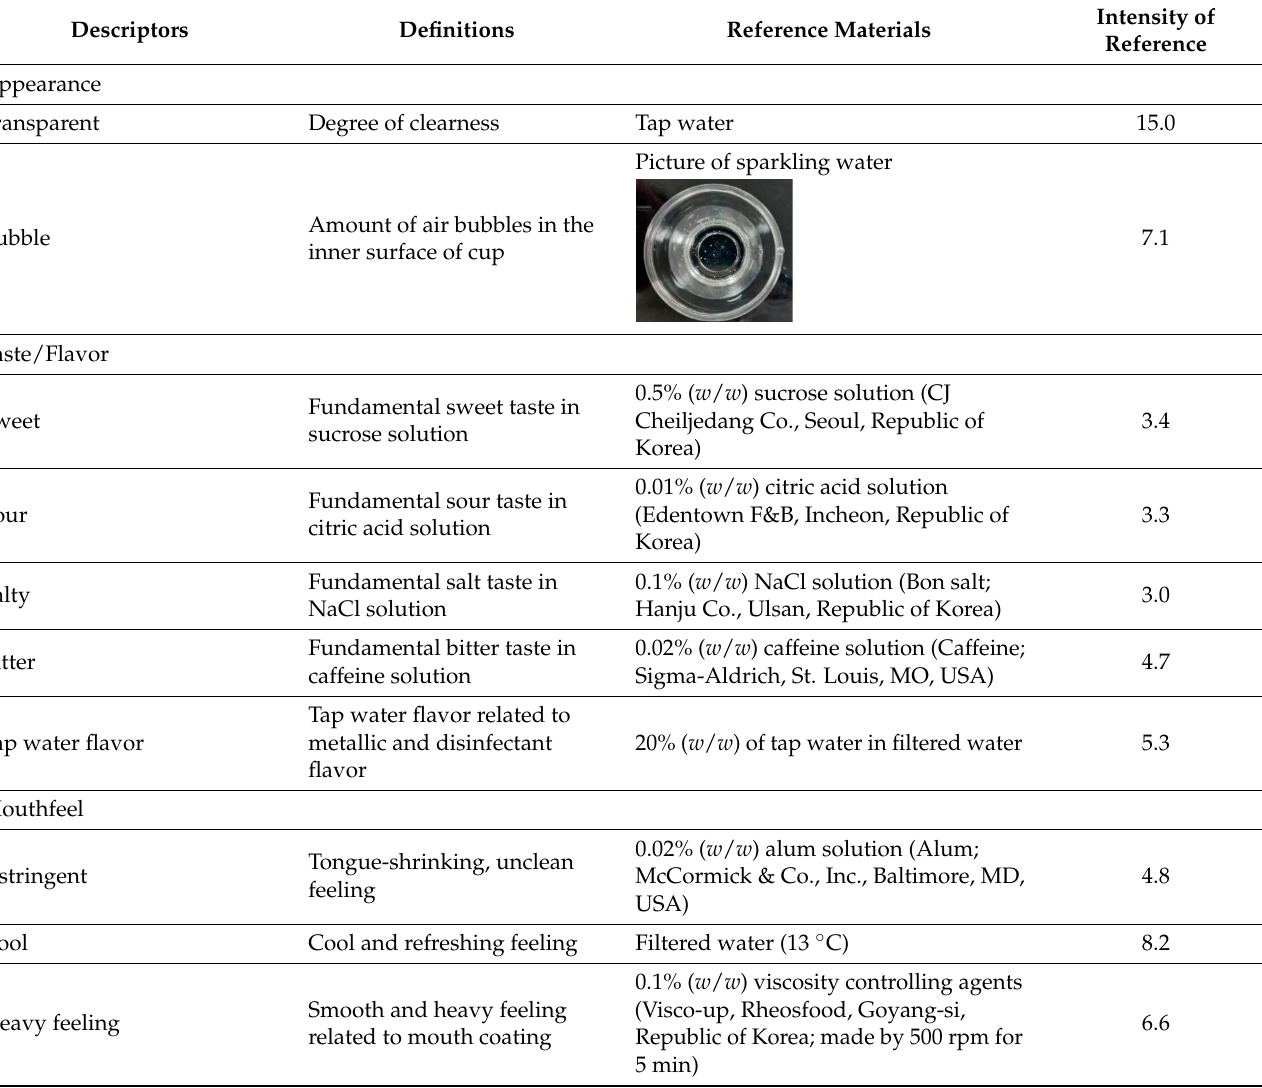
Table 2. Sensory attributes generated from 11 water